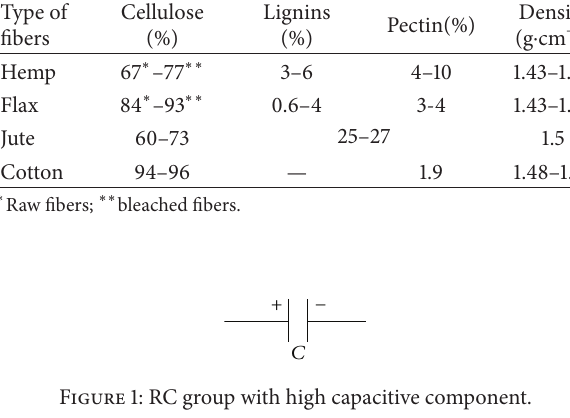
Figure 1: RC group with high capacitive component.